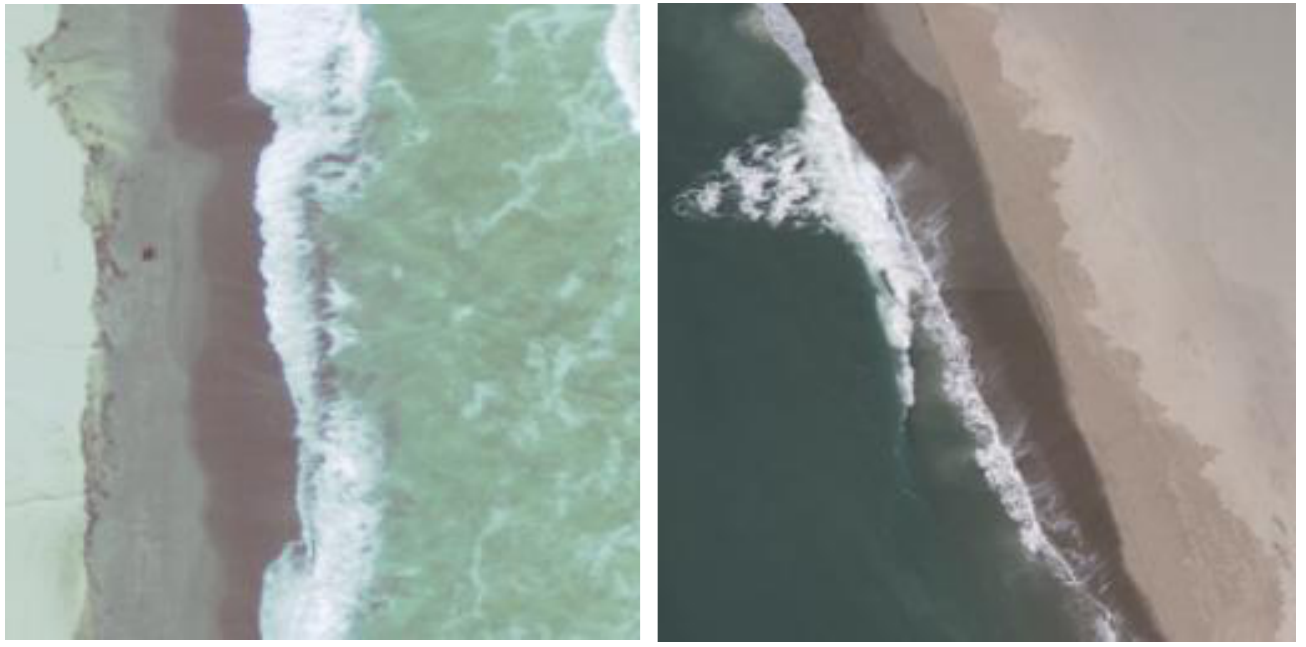
Figure 12. Two examples of the test images.